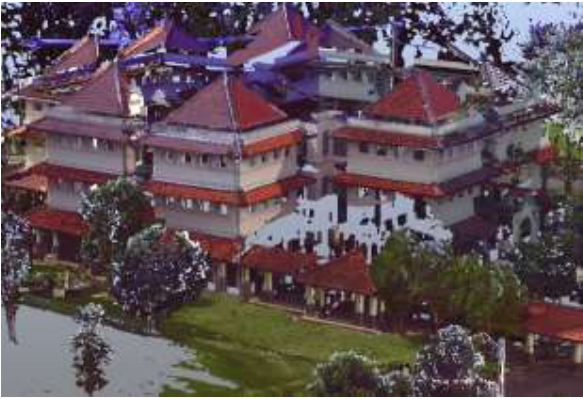
Figure 7. Dense Point Cloud of Library Building from TLS